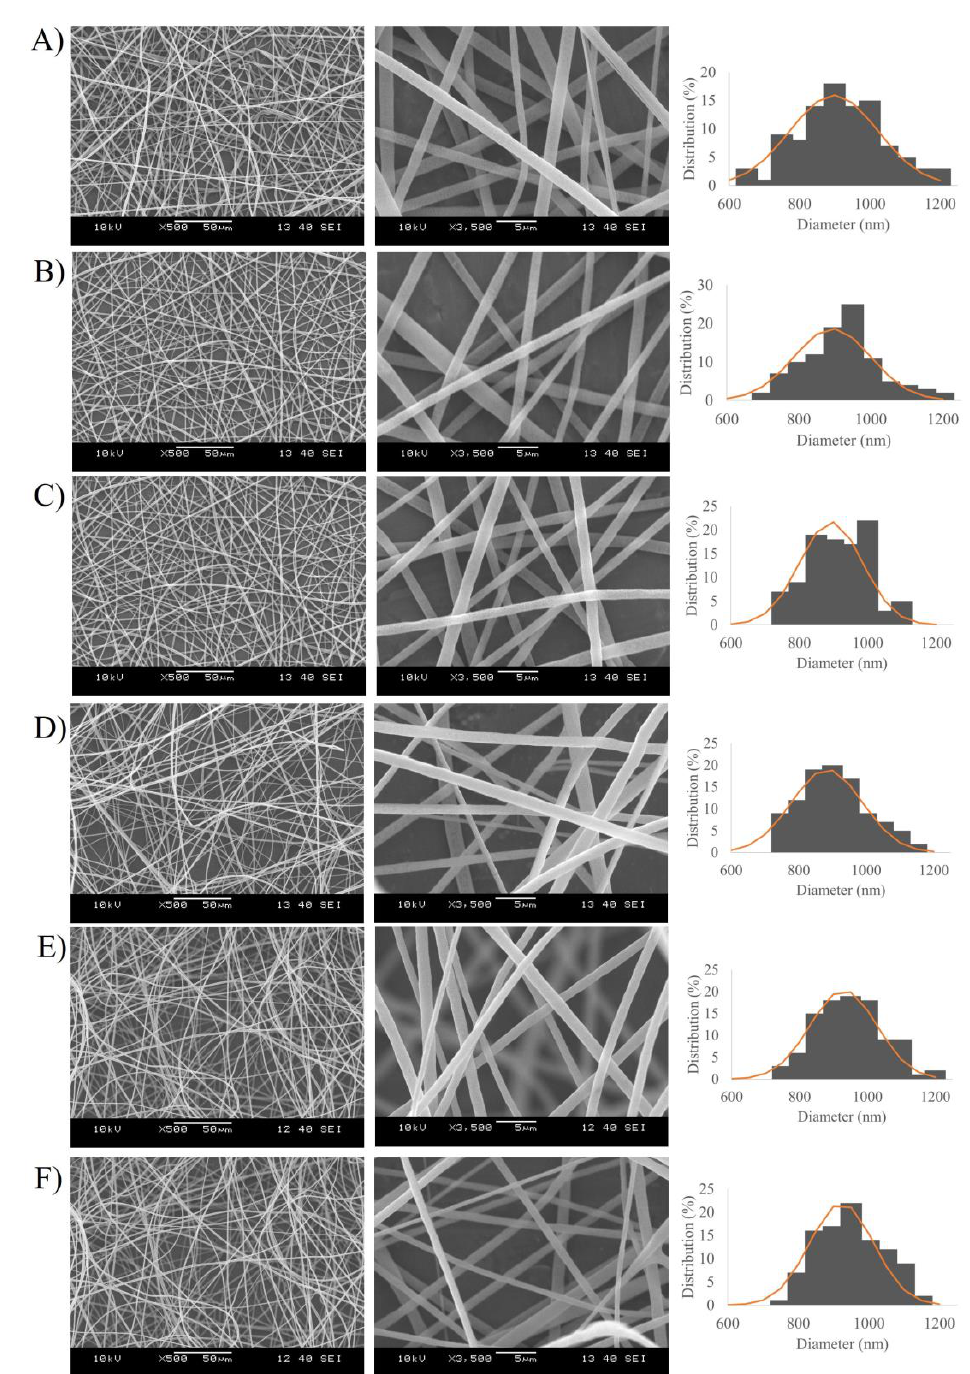
Figure 3. SEM images (magnification: 500 × and 3500 × ) and diameter distribution of Melatonin- loaded PLA nanofibers with different concentration of drug 0.1% w / w ( A ), 0.3% w / w ( B ), 0.5% w / w ( C ), and Melatonin-loaded PLA nanofibers with Tween ® 80 and different concentrations of drug 0.1% w / w ( D ), 0.3% w / w ( E ), 0.5% w / w ( F ).